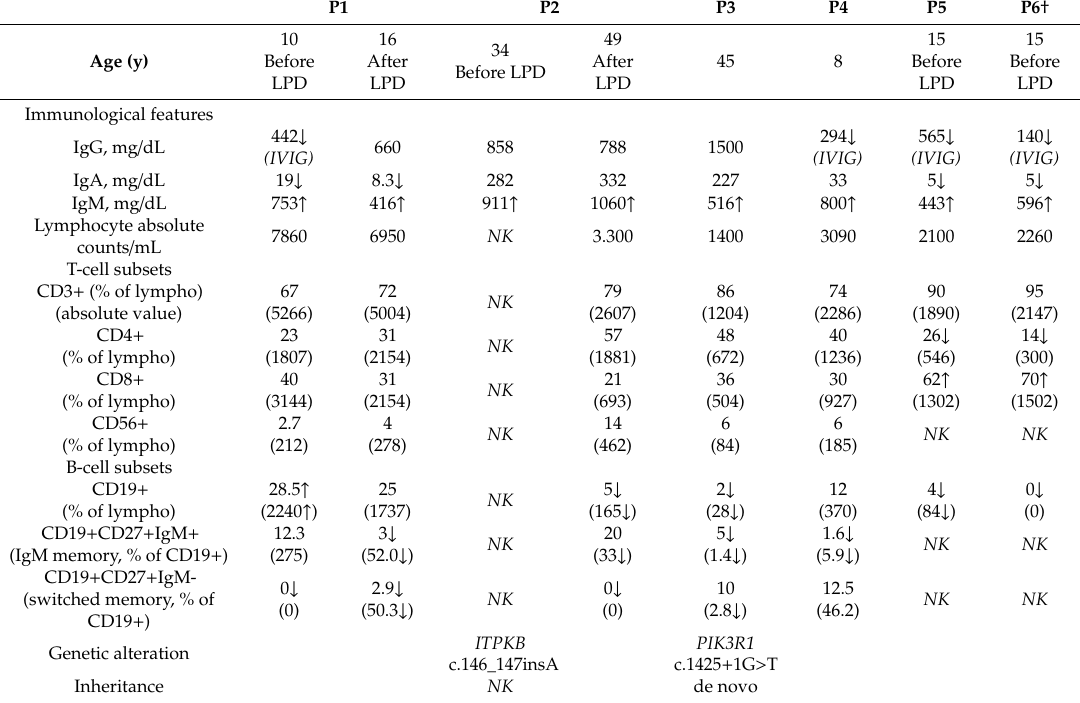
Table 2. Immunological and molecular findings of HIGM-like